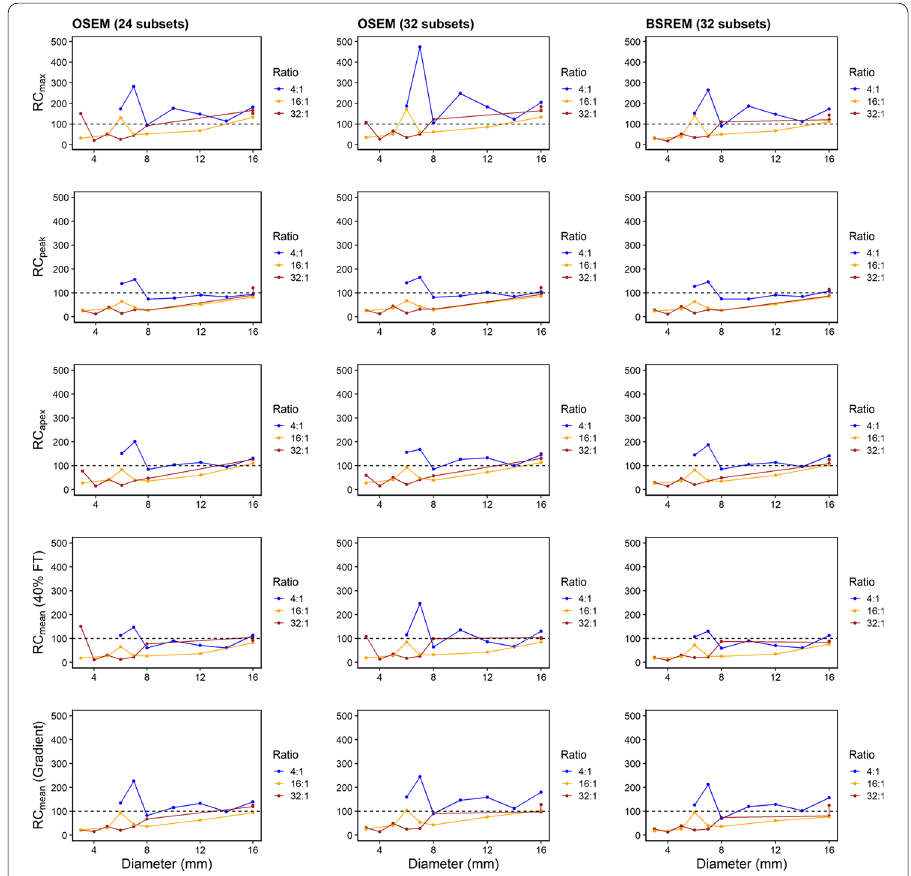
Fig. 10 Recovery curves for epoxy spheres with different 22 Na activity concentrations. (Top to bottom) Probe-IQ recovery concentration coefficients vs. lesion diameter using Max, Peak, Apex, and Mean (40% FT and gradient). (Left to right)—reconstruction algorithms using OSEM and BSREM. Each colour represents a different lesion-to-background activity